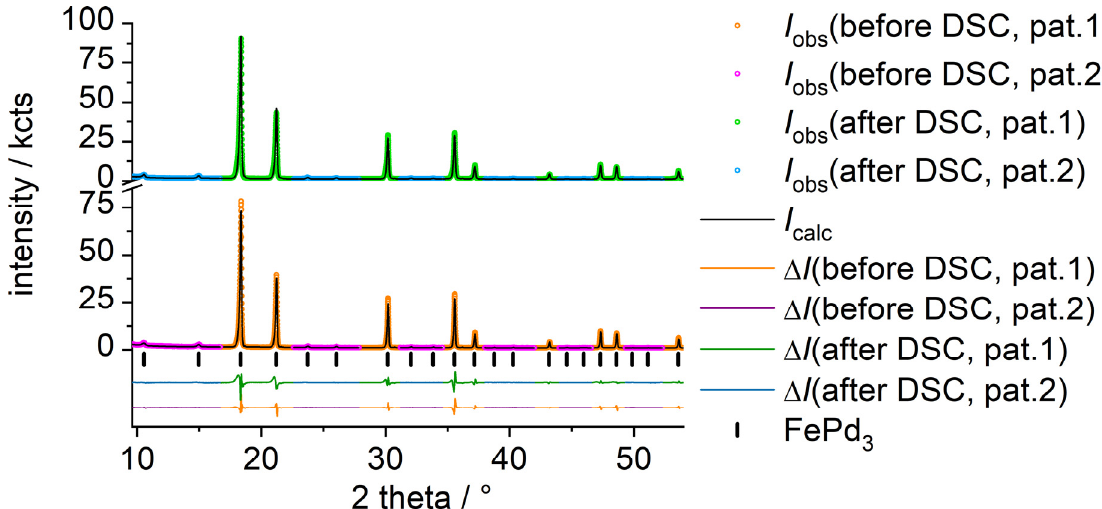
Figure A4. Rietveld refinement of the crystal structure of ordered FePd 3 before DSC (bottom, AuCu 3 type, Pm 3 (cid:3364) m , a = 385.330(5) pm, SOF (Fe, 1 a ) = 0.909(10), B iso (1a) = 0.35(9) 10 − 4 pm², B iso (3c) = 0.91(2) 10 − 4 pm², R Bragg (pat.1) = 2.83, R Bragg (pat.2) = 2192, R p (pat.1) = 0.089, R p (pat.2) = 0.020, R wp (pat.1) = 0.142, R wp (pat.2) = 0.025, GOF = 5.09) and after DSC (top, AuCu 3 type, Pm 3 (cid:3364) m , a = 385.433(3) pm, SOF (Fe, 1 a ) = 0.841(12), B iso (1a) = 0.96(12) 10 − 4 pm², B iso (3c) = 0.69(3) 10 − 4 pm², R Bragg (pat.1) = 4.10, R Bragg (pat.2) = 2150, R p (pat.1) = 0.131, R p (pat.2) = 0.024, R wp (pat.1) = 0.189, R wp (pat.2) = 0.030, GOF = 5.09) at 297(1) K based on XRPD powder diffraction data (Mo-K α 1 radiation, Huber G670) using Topas